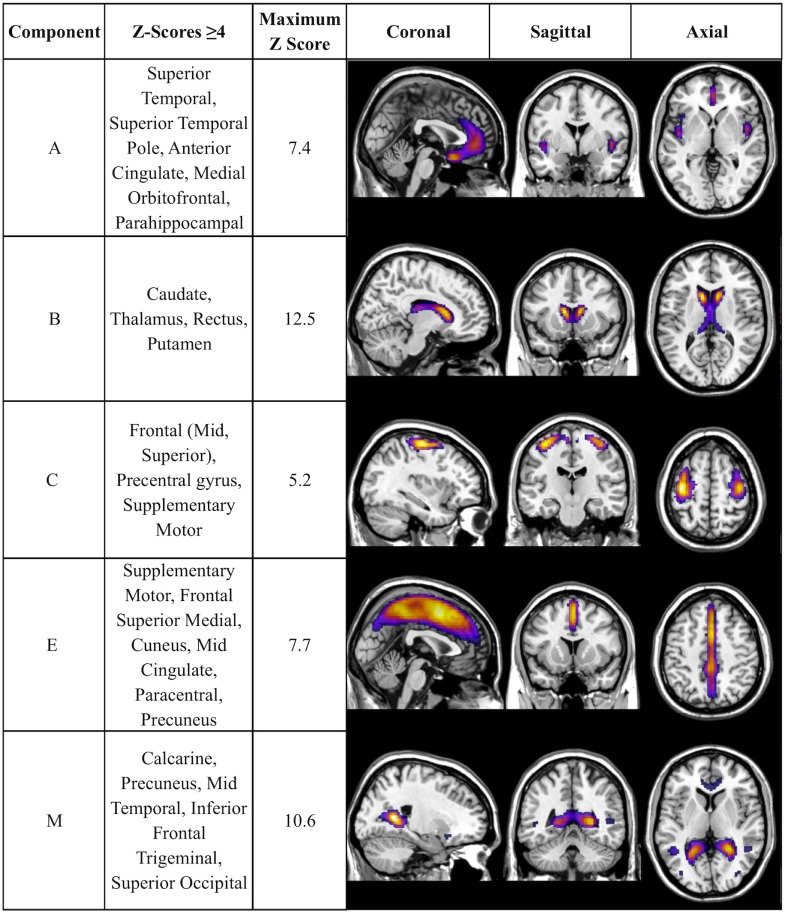
Components with strongest CAP-group significance (p ≤ 0.0001). Multiview topography of Table 2 components, thresholded between Z = 4.0 and the component’s maximum Z-score (presented in column 3) to optimize display of regions with highest Z-scores.